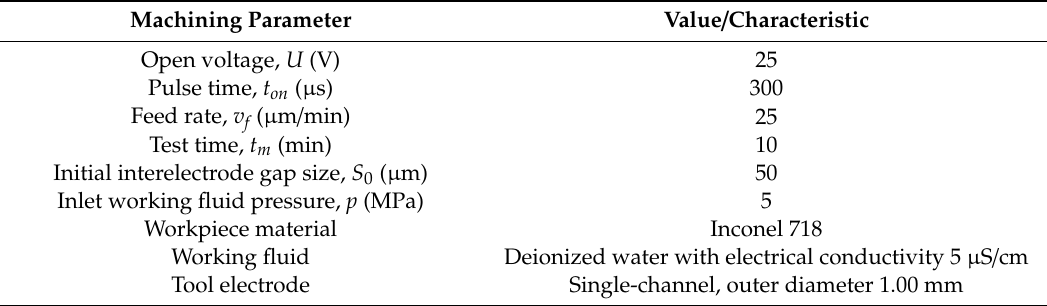
Table 6. Machining conditions for the electrochemical machining process (ECM).